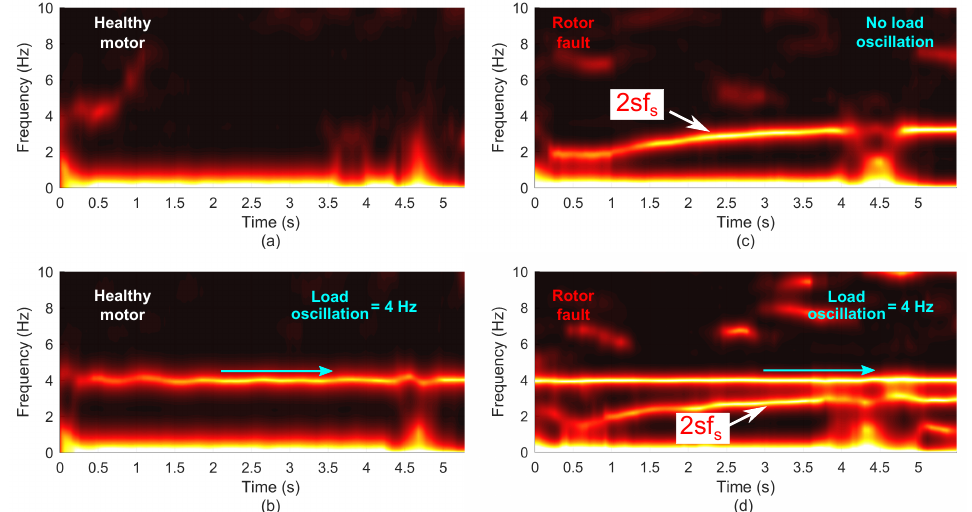
Figure 13. Time-frequency decomposition of the rotor speed under startup transient and high load level for: ( a ) healthy motor, ( b ) healthy motor and load oscillation, ( c ) rotor with a broken rotor bar without load oscillation, and ( d ) rotor with a broken rotor bar with load